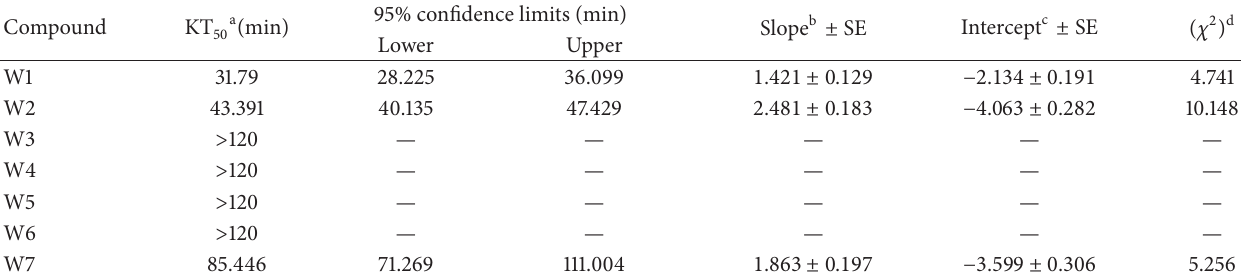
Table 3: Knockdown time (KT 50 ) of different monoterpenes incorporated in wax against female adult Cx. pipiens . Compound